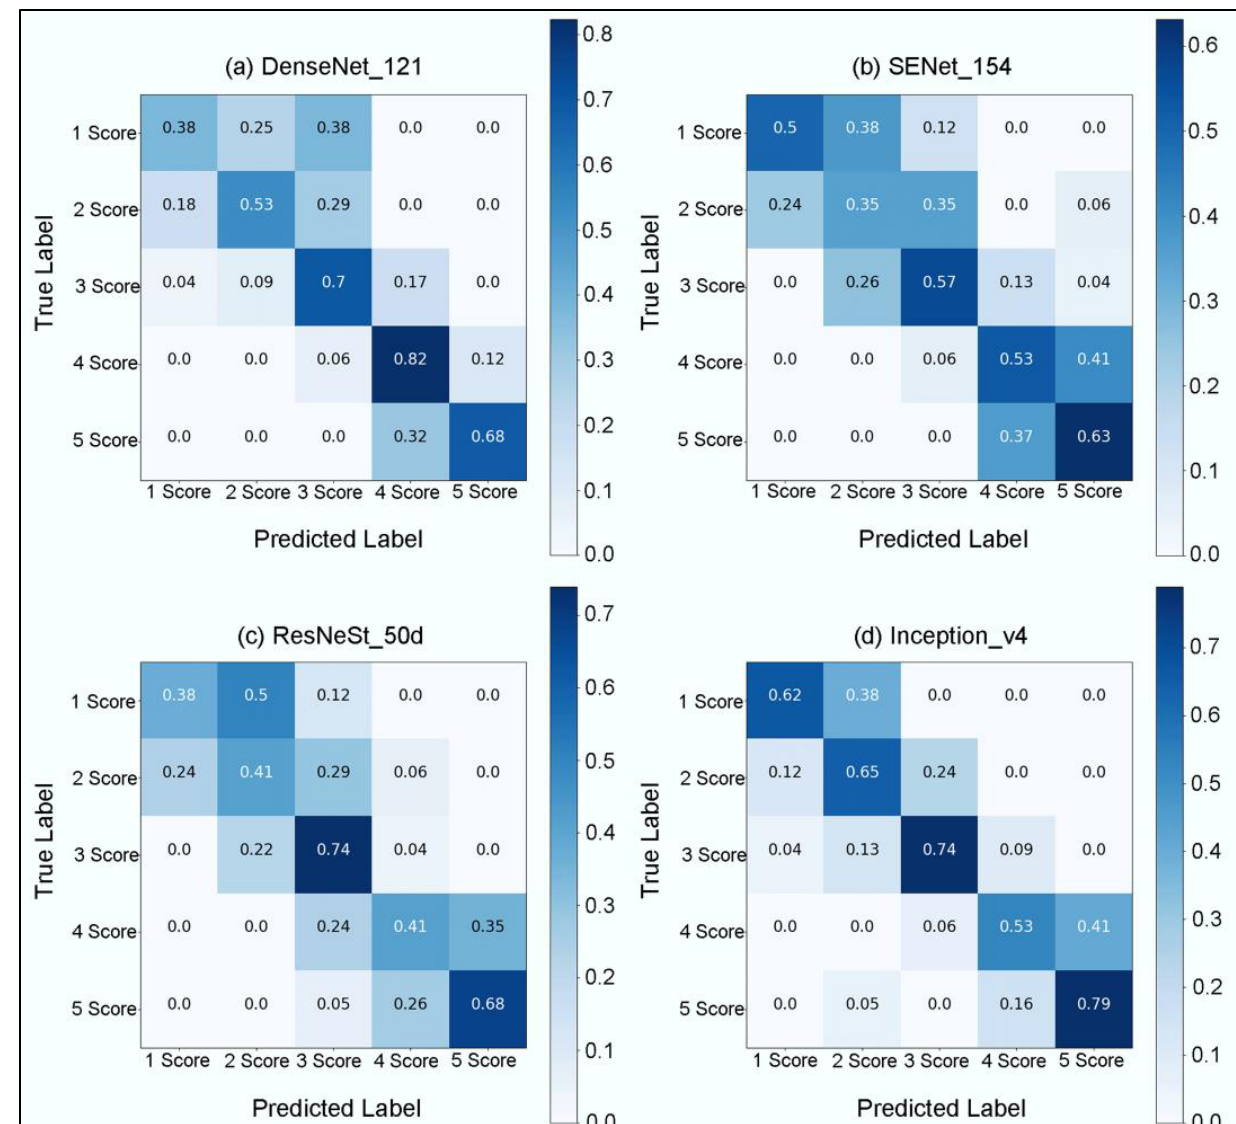
learning model. When predicting the 1 to 5 ratings of willingness to stay, the accuracy of